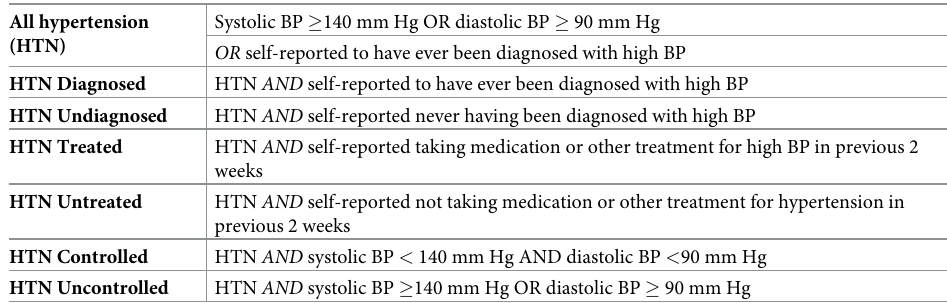
Table 1. Definitions of hypertension